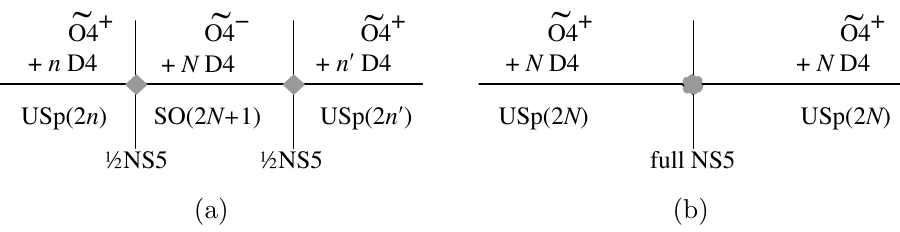
Figure 5 . (a) The IIA brane setup to engineer SO(2 N +1) gauge theories with n + n 0 (cid:13)avors. This requires the use of two half-NS5-branes. (b) When we collapse the two half-NS5-branes, we obtain the IIA reduction for the R 2 ; 2 N